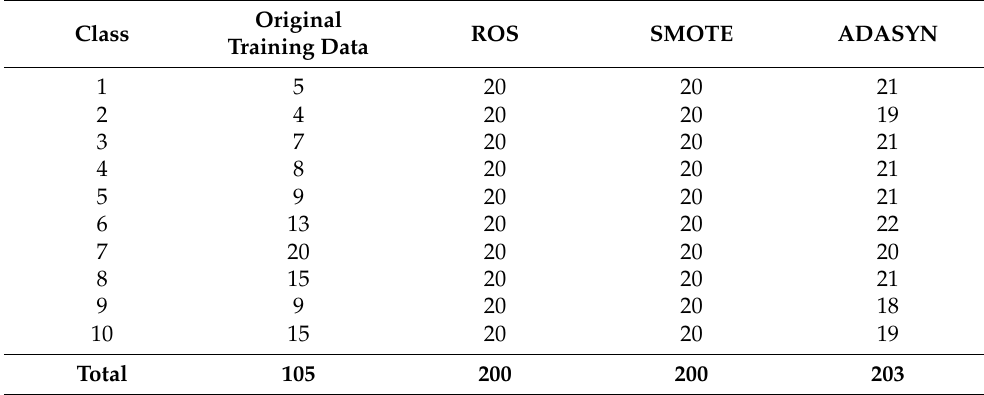
Table 6. The number of samples for each class of the original training data for SRMT and the new training data with the oversampling techniques.